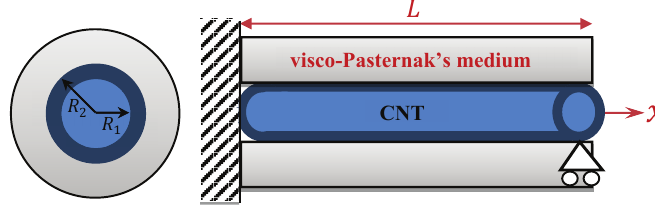
Figure 1. Schematic diagram for clamped-supported carbon nanotube embedded in visco-Pasternak’s